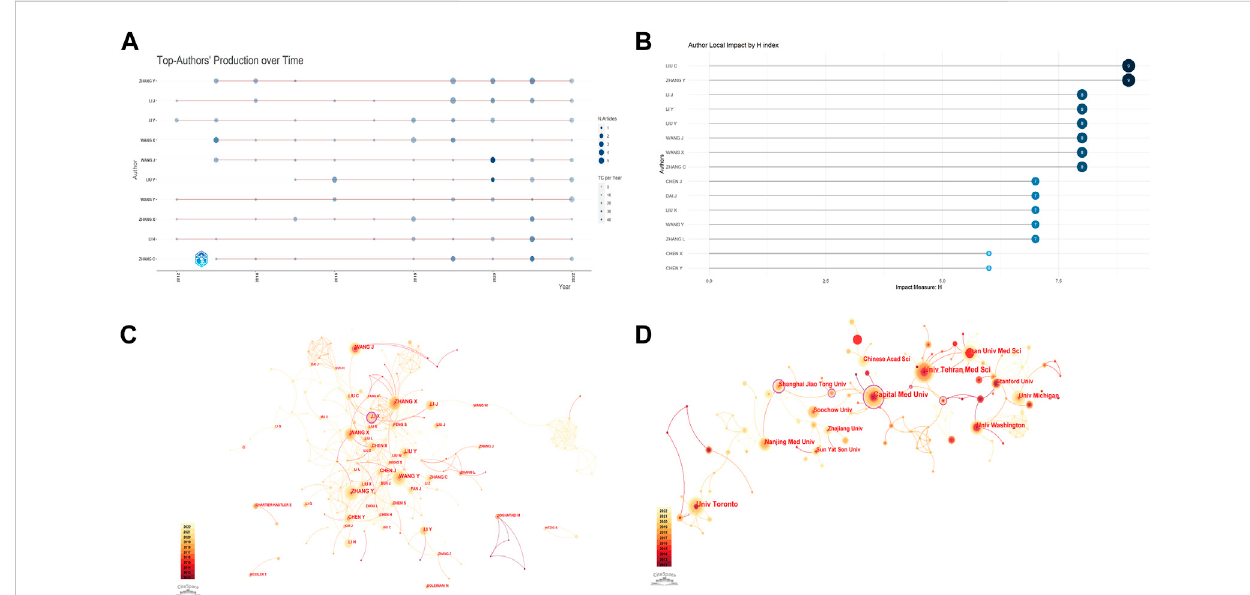
FIGURE 3 Visualization of active institutes and authors analysis. (A) Timeline distribution of top 10 most productive authors. Red line, temporal distribution of author-relatedpublications;circlediameter,numberofpublications;lightblue,totalcitationsperyear. (B) h-indexofpublicationsfromdifferentauthors. (C) Cluster analysis of cooperation among authors. (D) Cluster analysis of cooperation institutes.